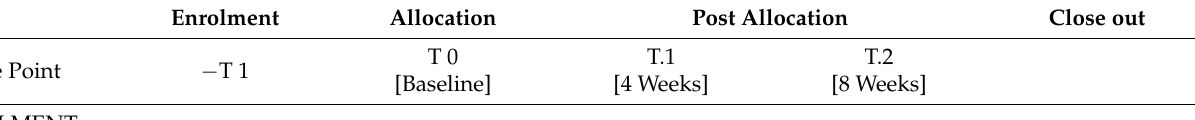
Table 1. Schedule of enrolment, interventions, and assessments.